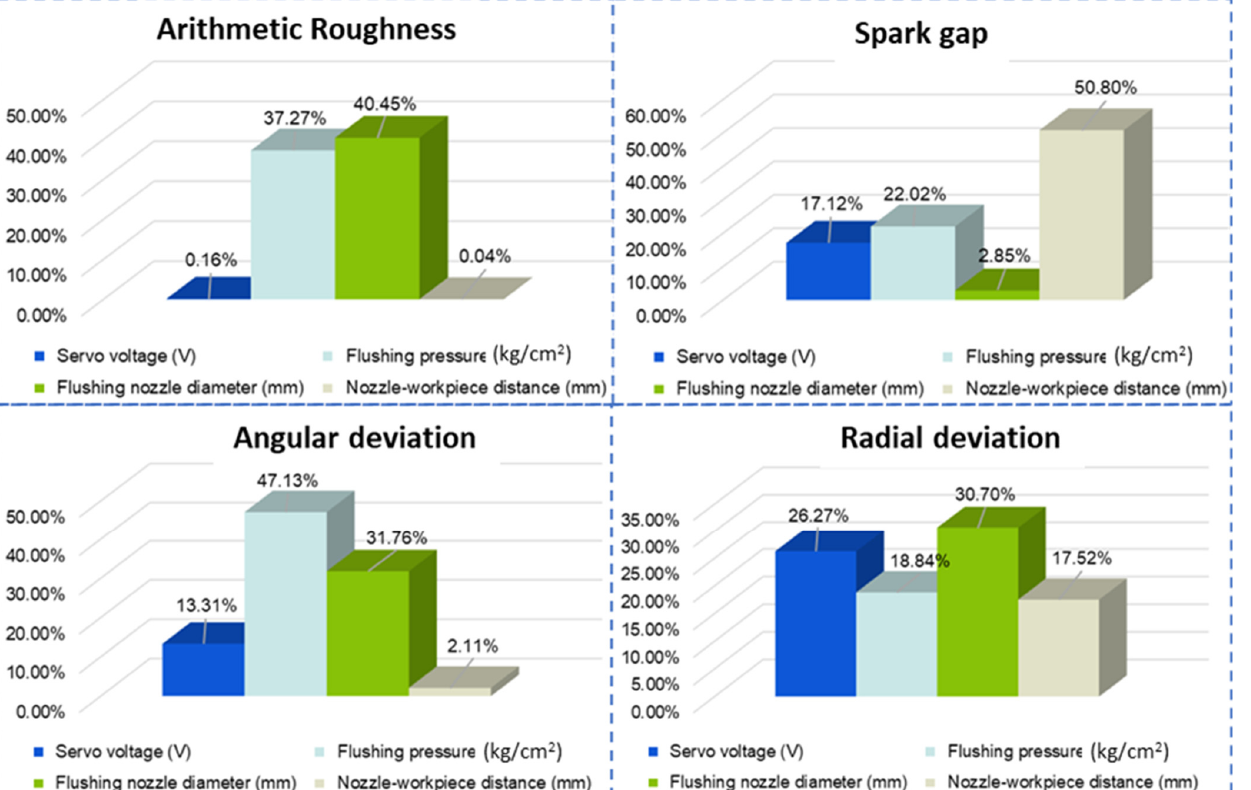
Figure 6. Percentage contribution ratio of WEDM process parameters in controlling the responses.